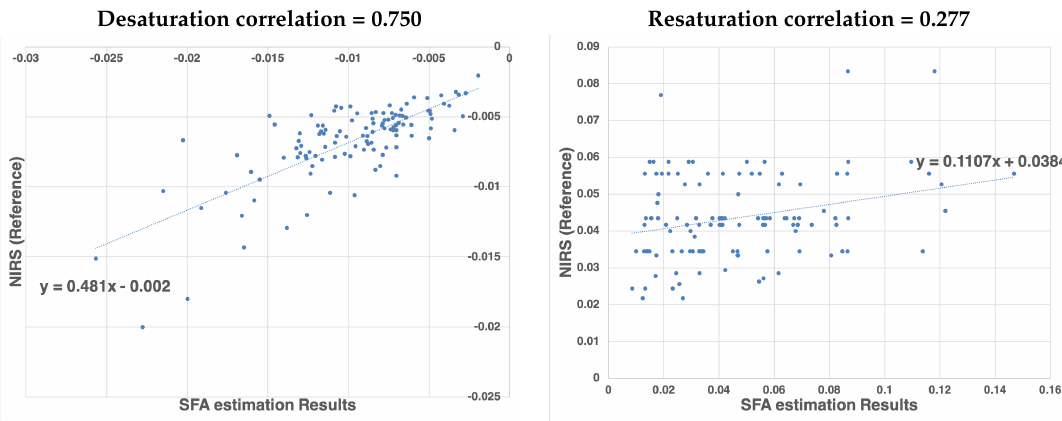
Figure 16. Correlation of de-saturation ( left ) and re-saturation ( right ) slope numbers between the proposed SFA setup and the clinical standard NIRS